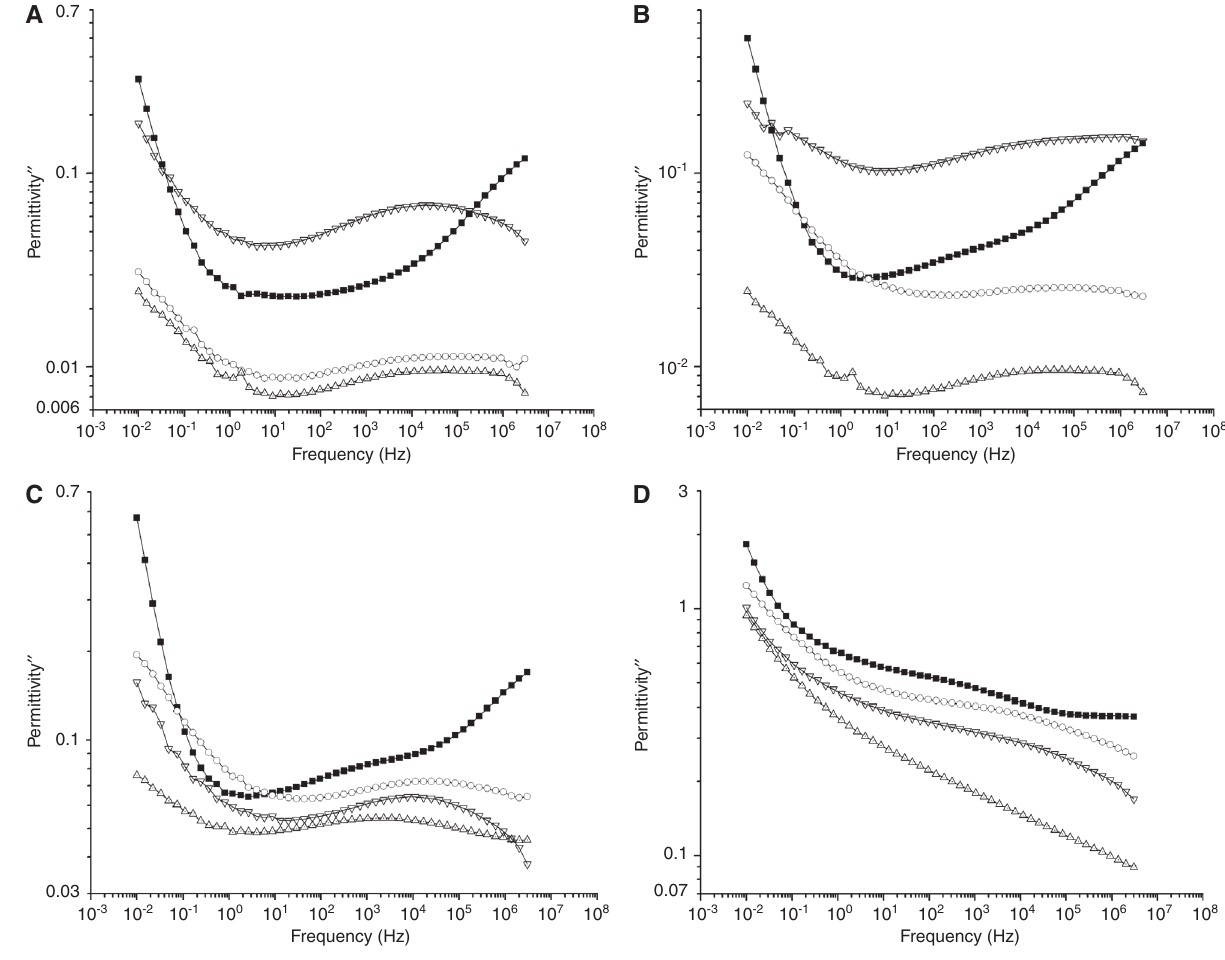
Figure 6 Dielectric loss ( ε ″) at 30 ° C related to the frequency. (A) Compound+5% GTR, (B) compound+10% GTR, (C) compound+20% GTR, and (D) compound+50% GTR: ■, EVA; ○, HDPE; ∆, PP; ,